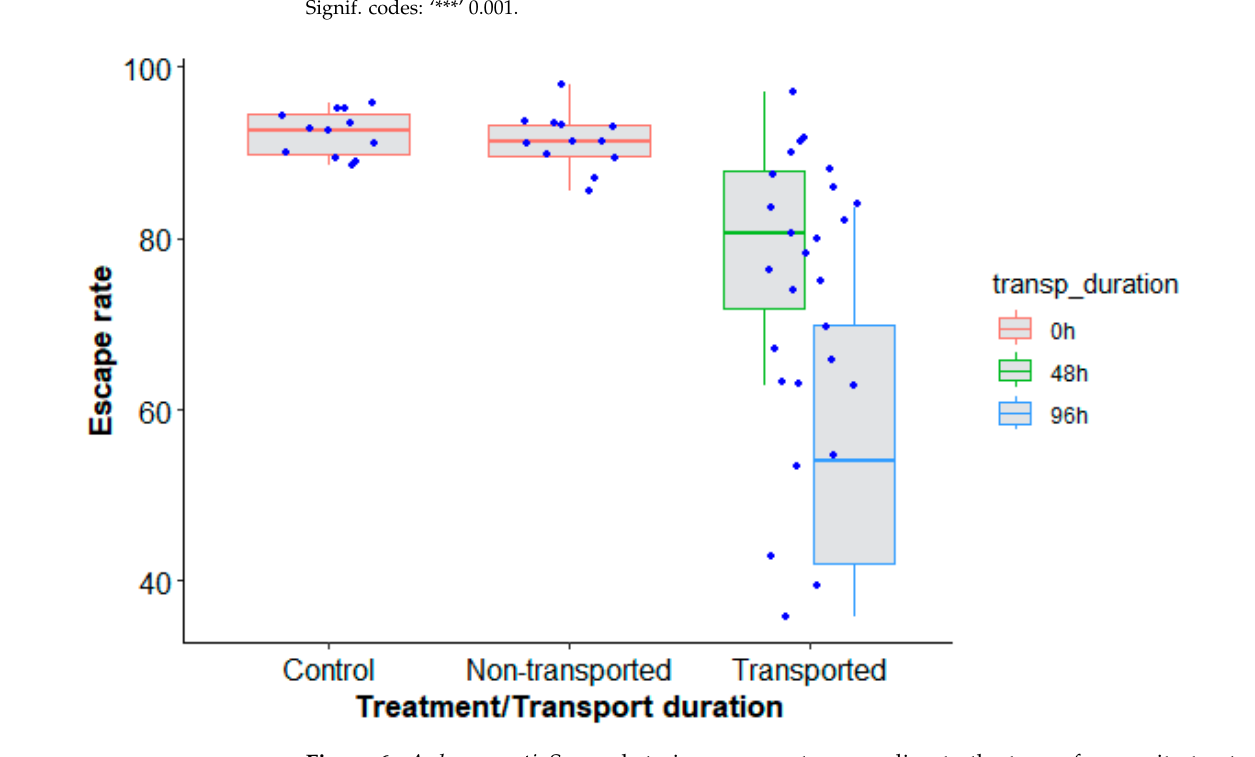
Figure 6. Aedes aegypti , Senegal strain, escape rates according to the type of mosquito treatment (control, transported and nontransported) and duration of transport (0 h (control and nontransported), 48 h and 96 h). Black bars indicate the median. The upper and lower limits of each box indicate the interquartile range. Each blue dot represents a value of the observed escape rate per replicate.